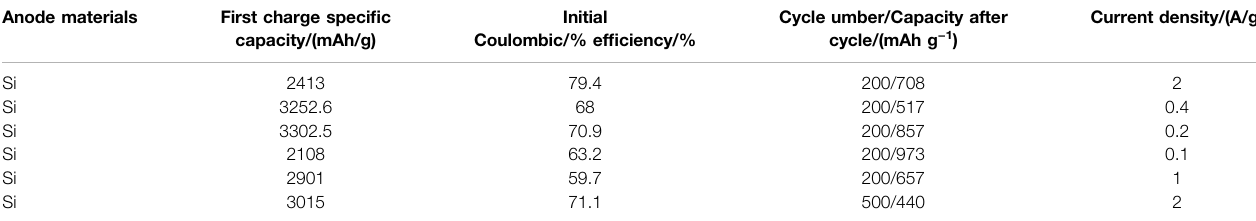
TABLE 2 | Electrochemical performance of silicon anode in existing research.